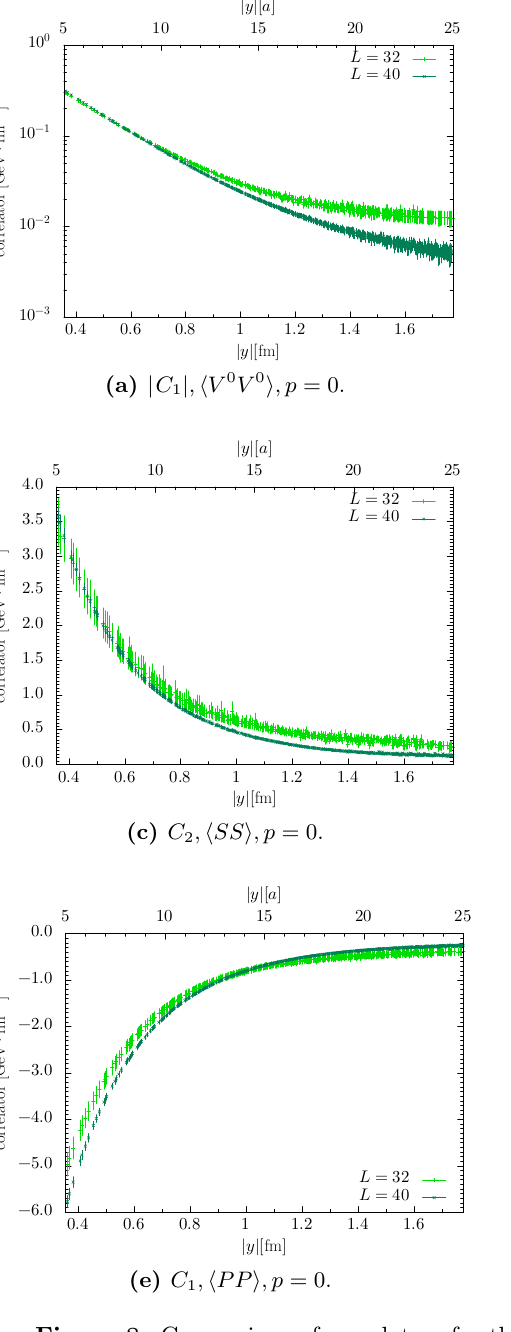
Figure 8. Comparison of correlators for the two spatial volumes used in our